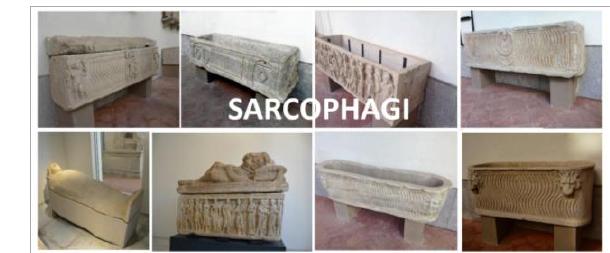
Figure 7. The sarcophagi category: step 1